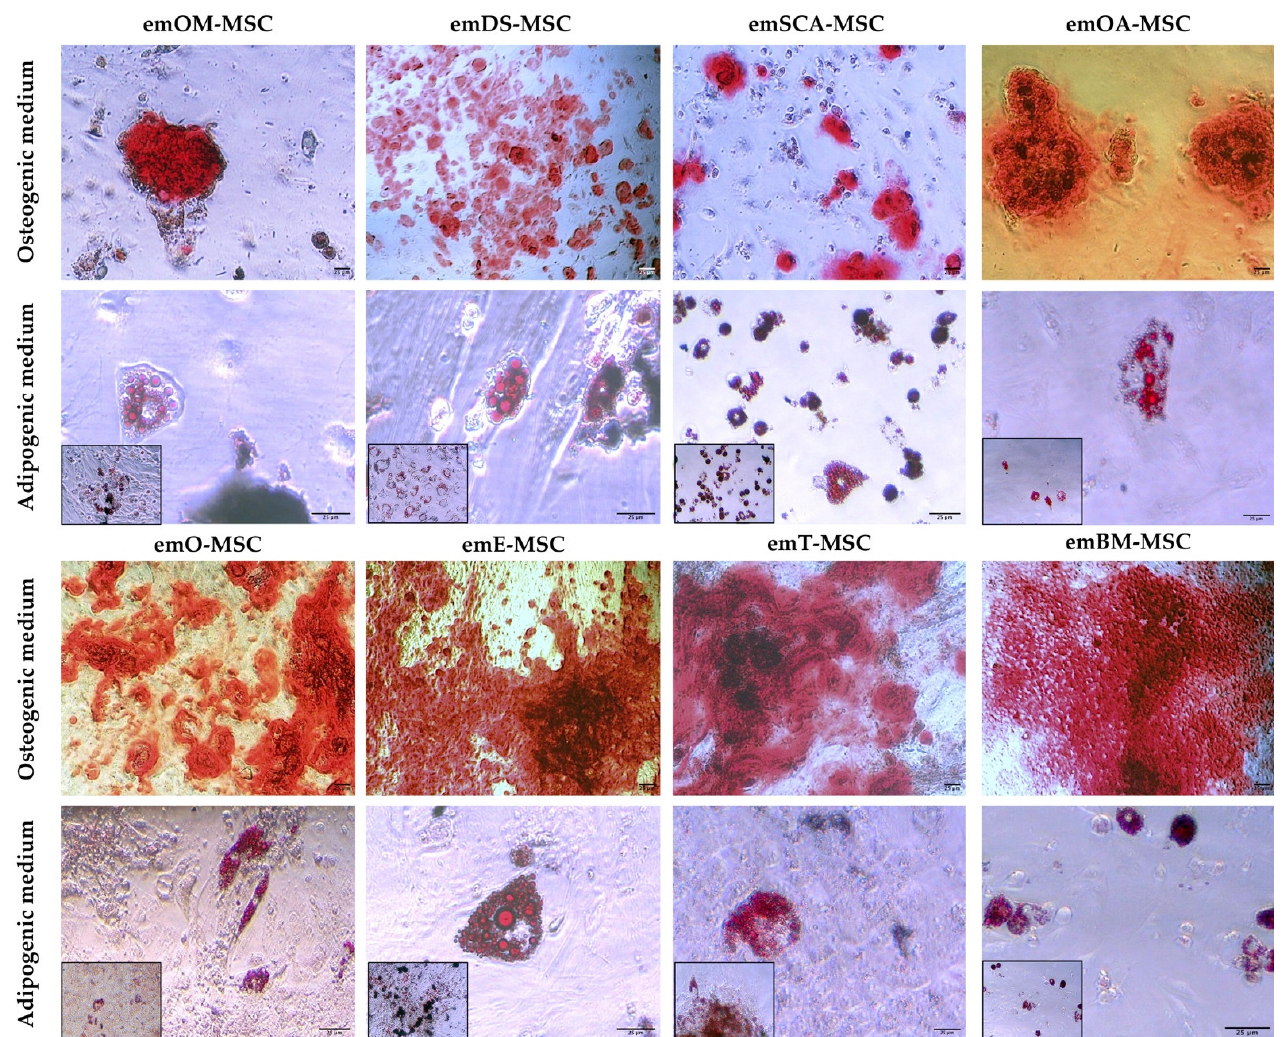
Figure 4. In vitro differentiation of emMSC to different lineages. Images show Alizarin Red S staining of calcium deposits in cells cultured in osteogenic differentiation medium (top panels); and Oil red O staining of lipid droplets in cells cultured in adipogenic differentiation medium (bottom panels). Bright-field images were acquired with 100× magnification (bars = 25 μm) for top panels and with 400× or 200× magnification (bars = 25 μm) for bottom panels.